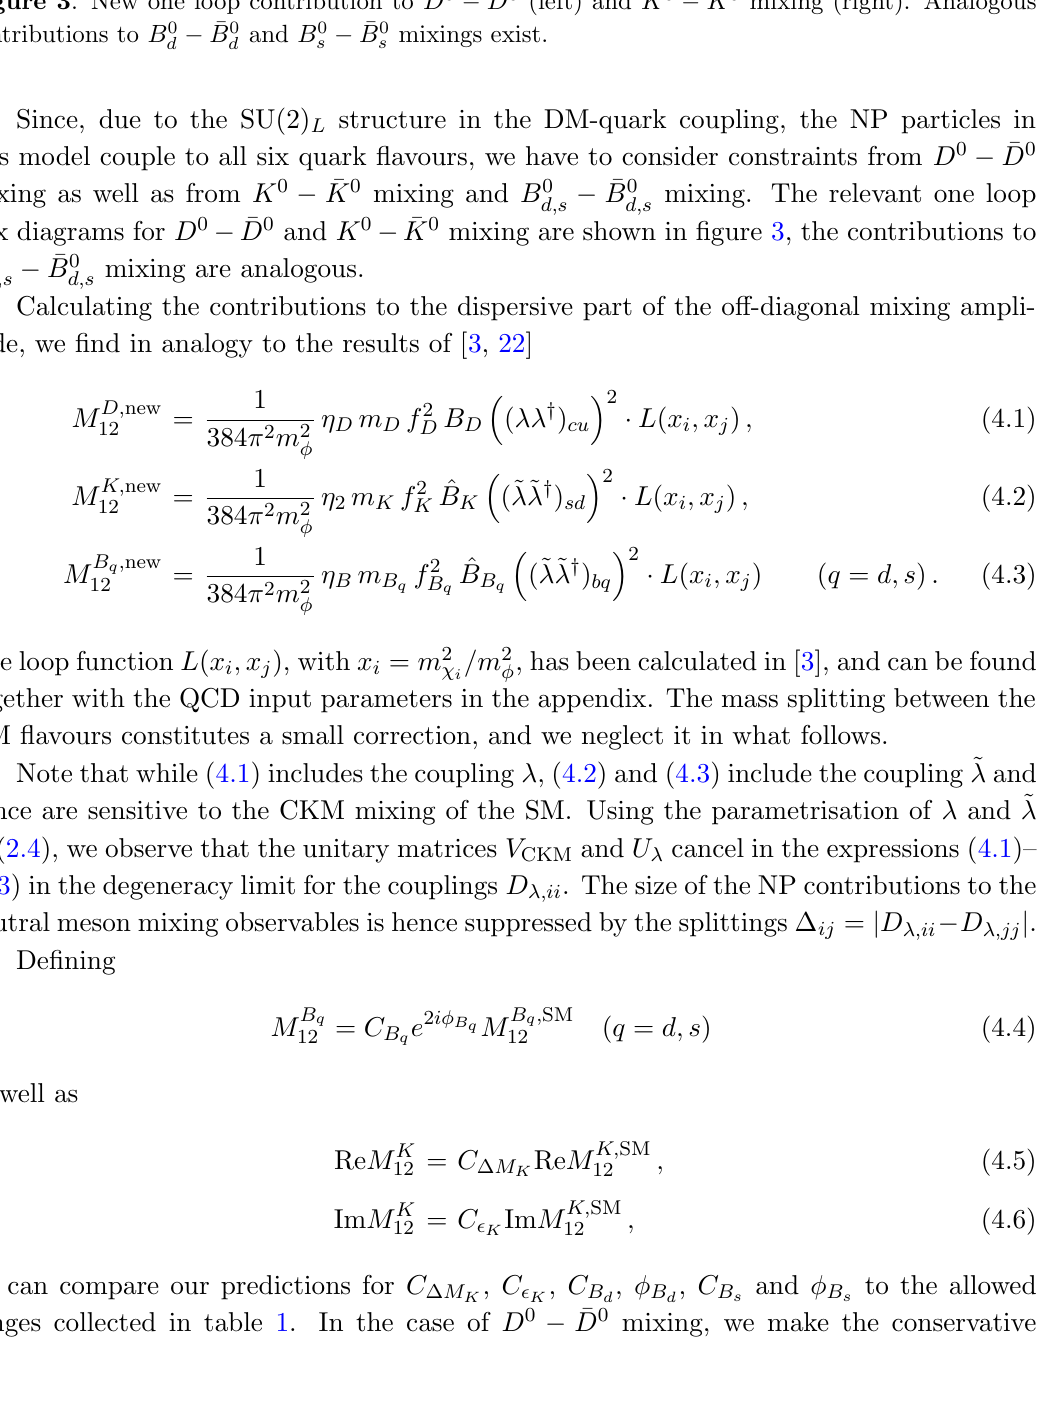
(cid:0) (cid:22) B 0 and B 0 (cid:0) (cid:22) B 0 mixings s s d d